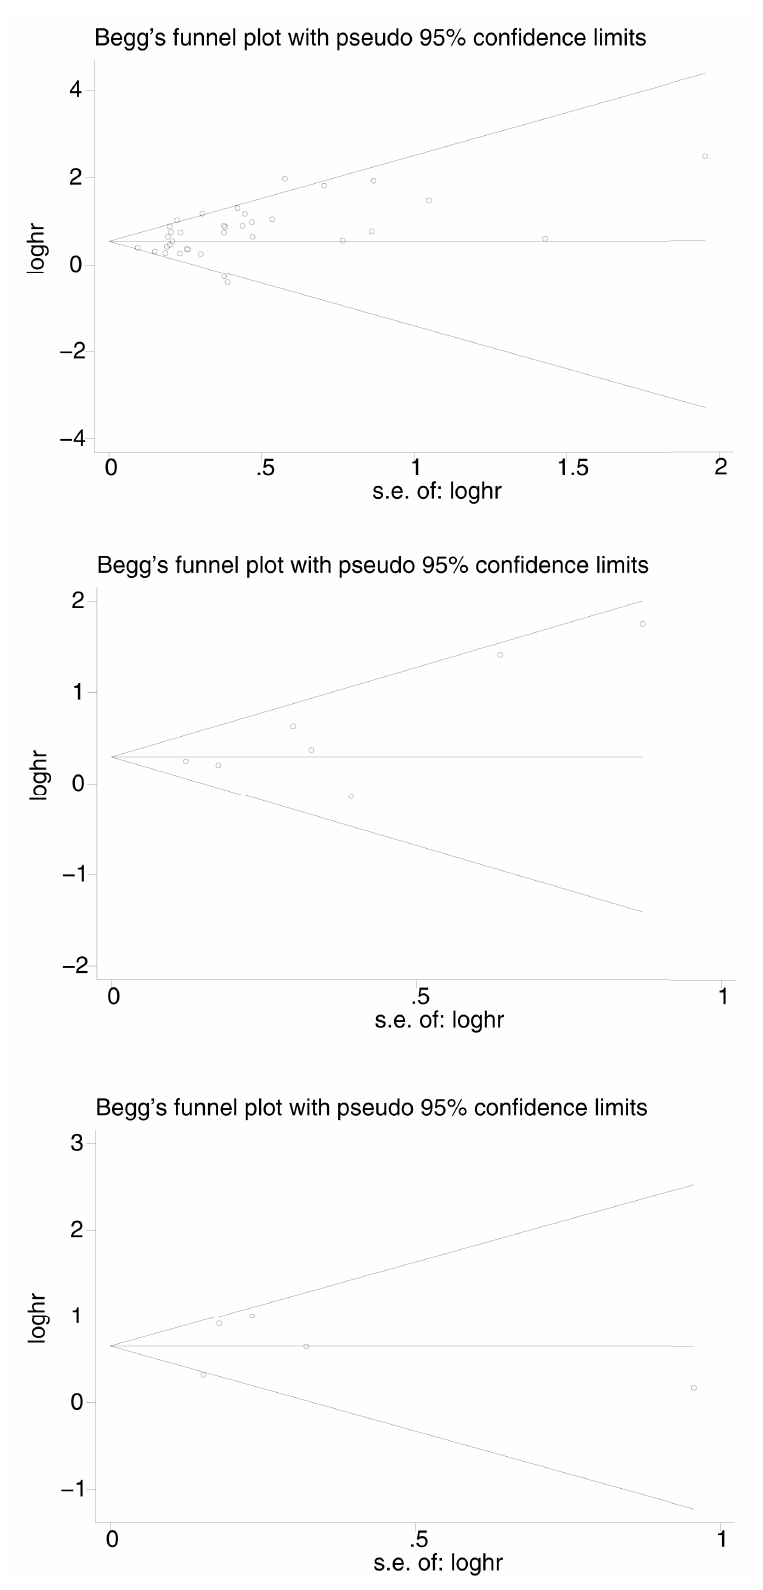
Fig 5. Begg’s funnel plots for the studies involved in the meta-analysis. A. overall survival B: progression free survival. C. disease free survival. Abbreviations: loghr, logarithm of HRs; s.e., standard error. https://doi.org/10.1371/journal.pone.0233629.g005 PLOS ONE | https://doi.org/10.1371/journal.pone.0233629 May 29,